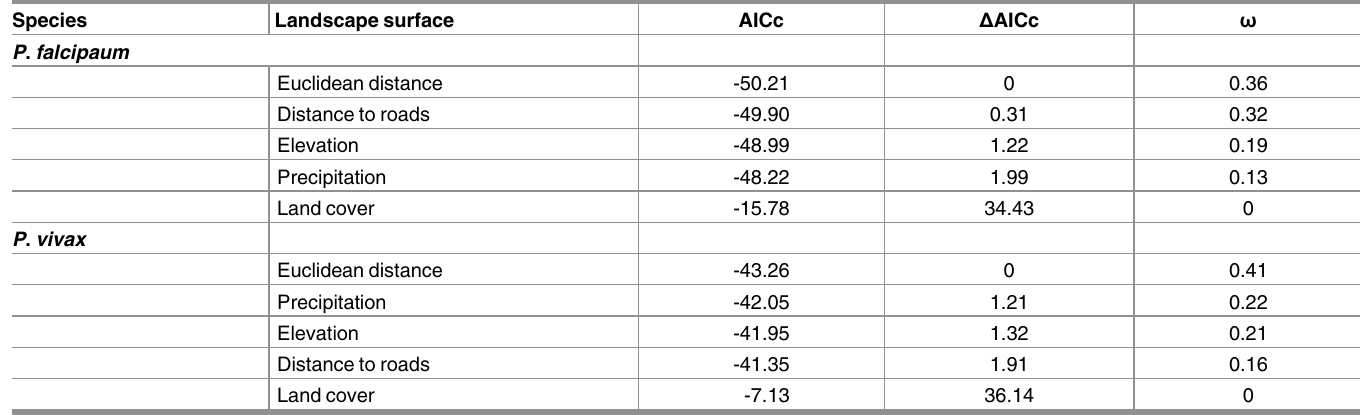
Table 3. Model fitness of resistance surfacesto pairwise F ST values calculated using ResistanceGA. AICc: corrected Akaike Information Criterion; ω : Akaike weight. Species